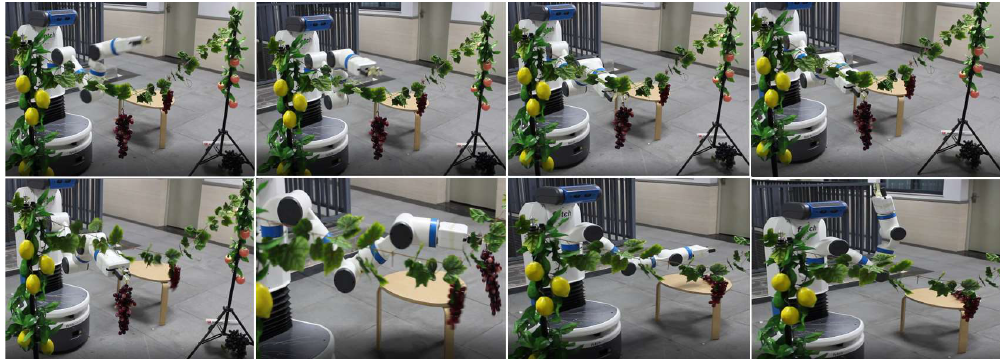
Figure 13. Video frames showing the robot reaching a cluster of plastic grapes, cutting the peduncle, and placing them onto a table.